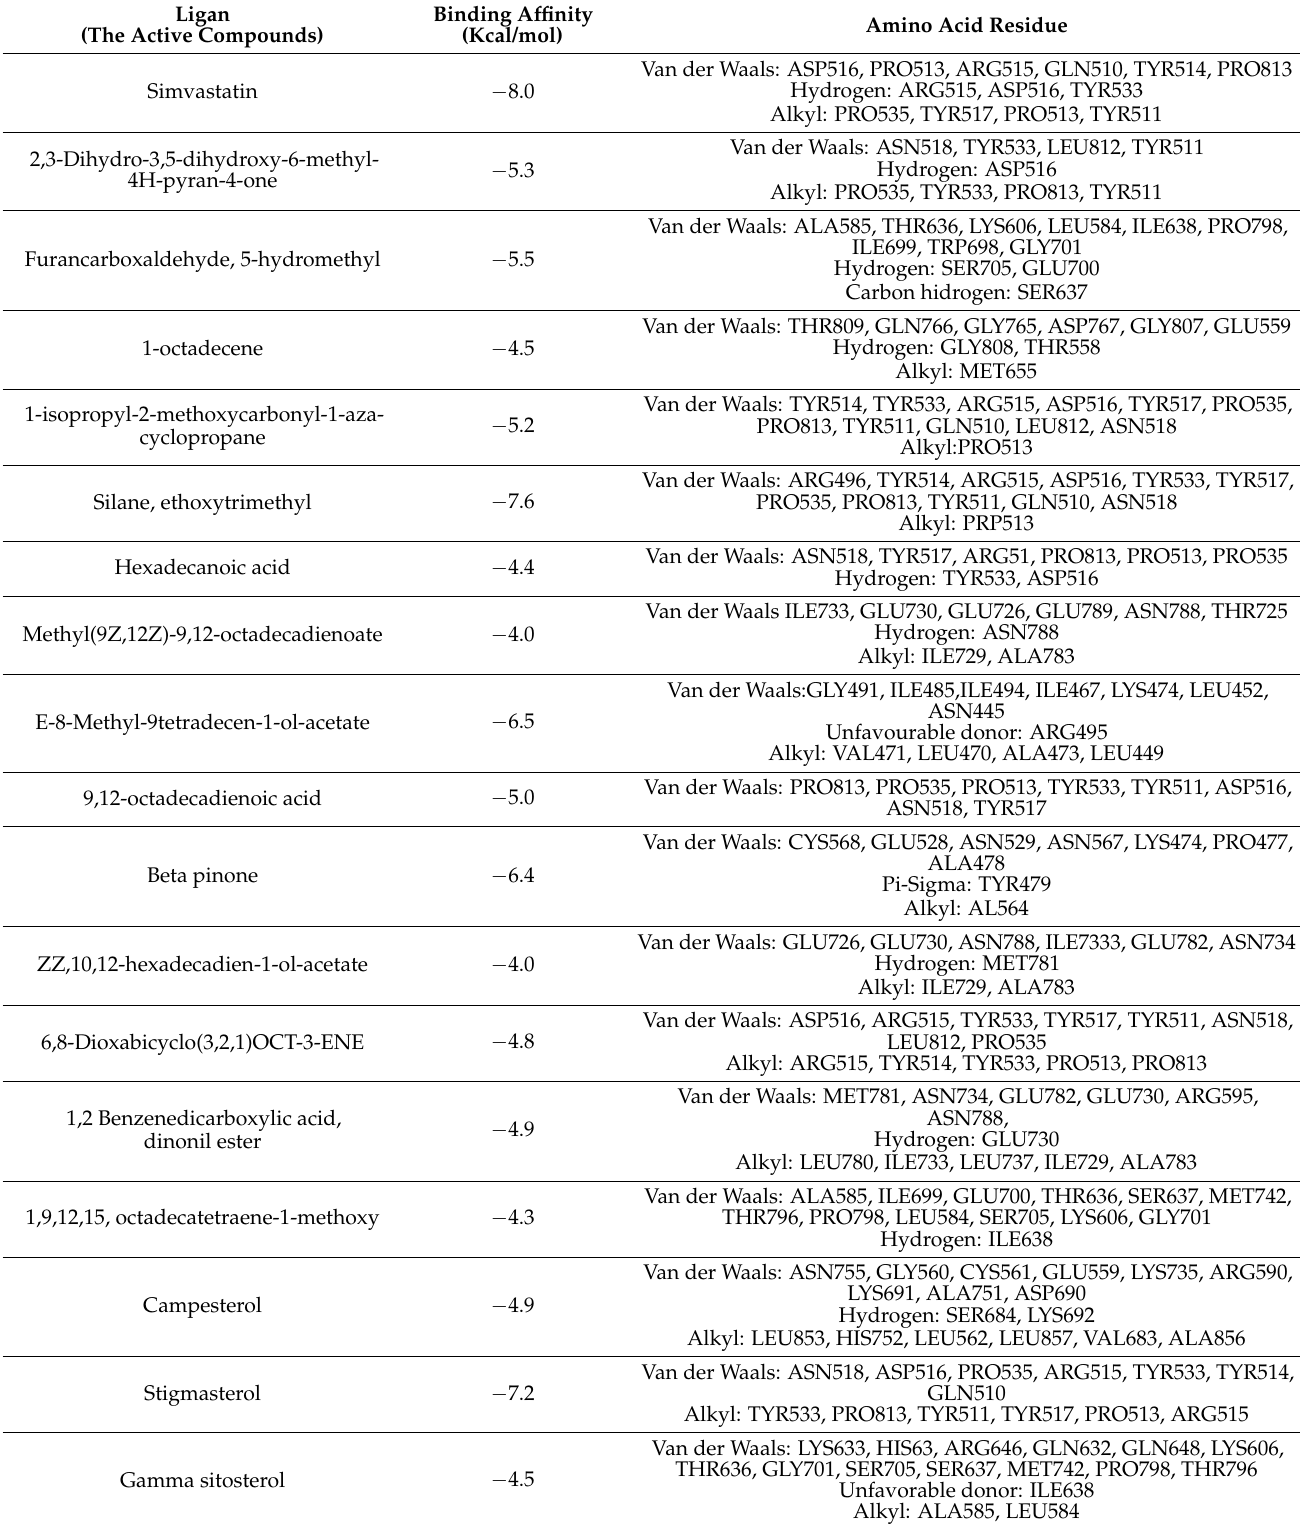
Table 3. Molecular docking of the active compounds in the ethanolic extract from Tacca tuber and